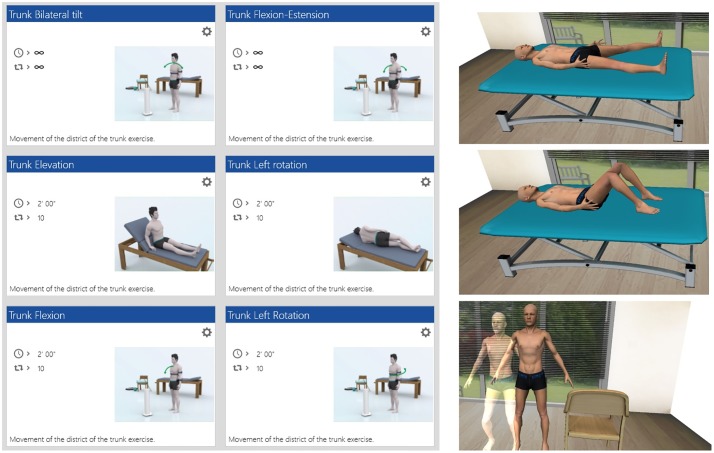
VR-based rehabilitation.Figure displays example zs of exercises performed by the participants using the virtual reality system. Subjects wore sensors on hips and/or sternum and were asked to perform movements in front of the computer where an avatar and virtual objects reproduced online the virtual movements.